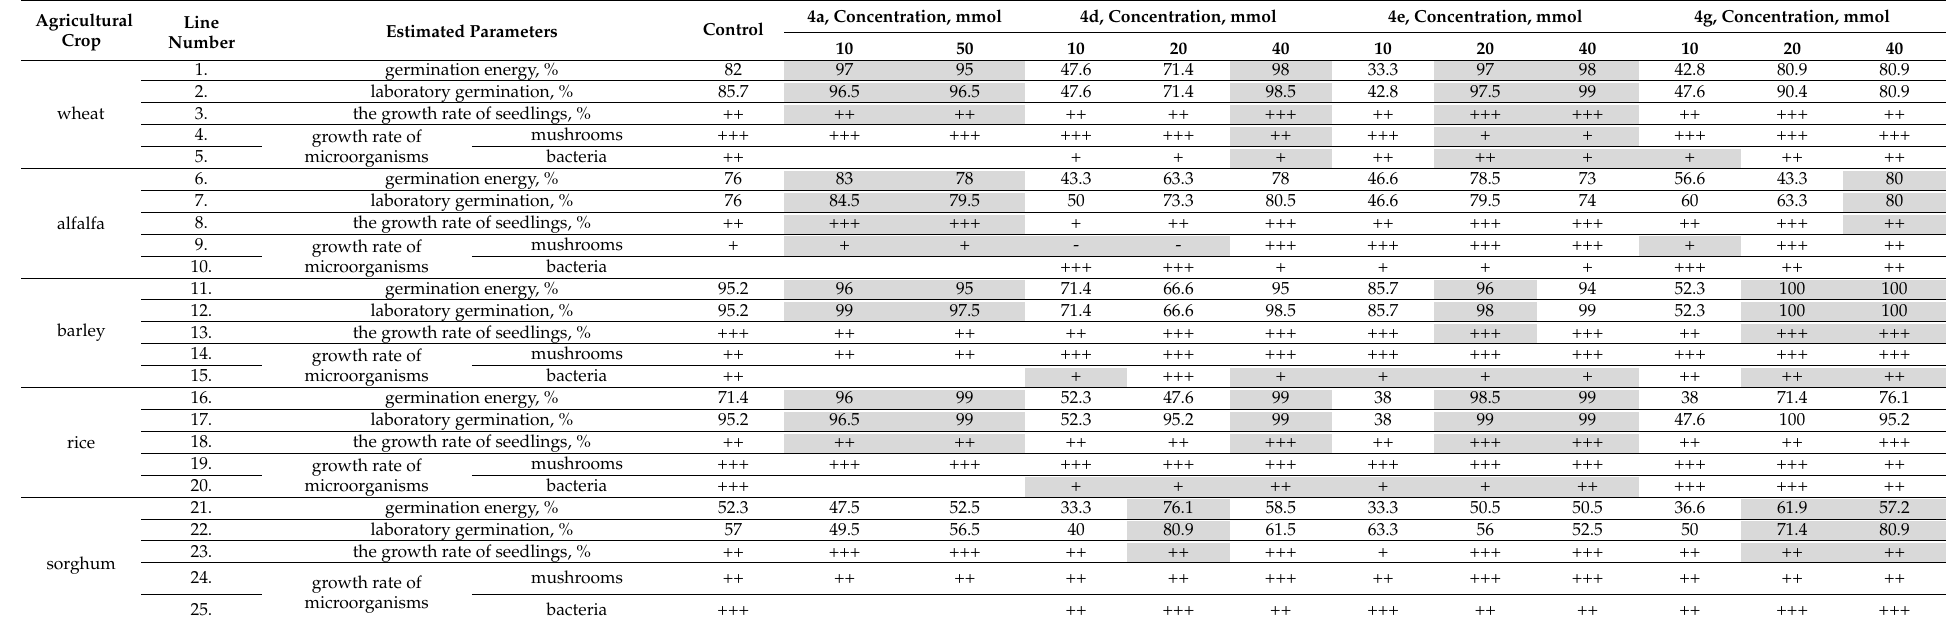
Table 3. Effect of seed treatment with test compounds on sowing